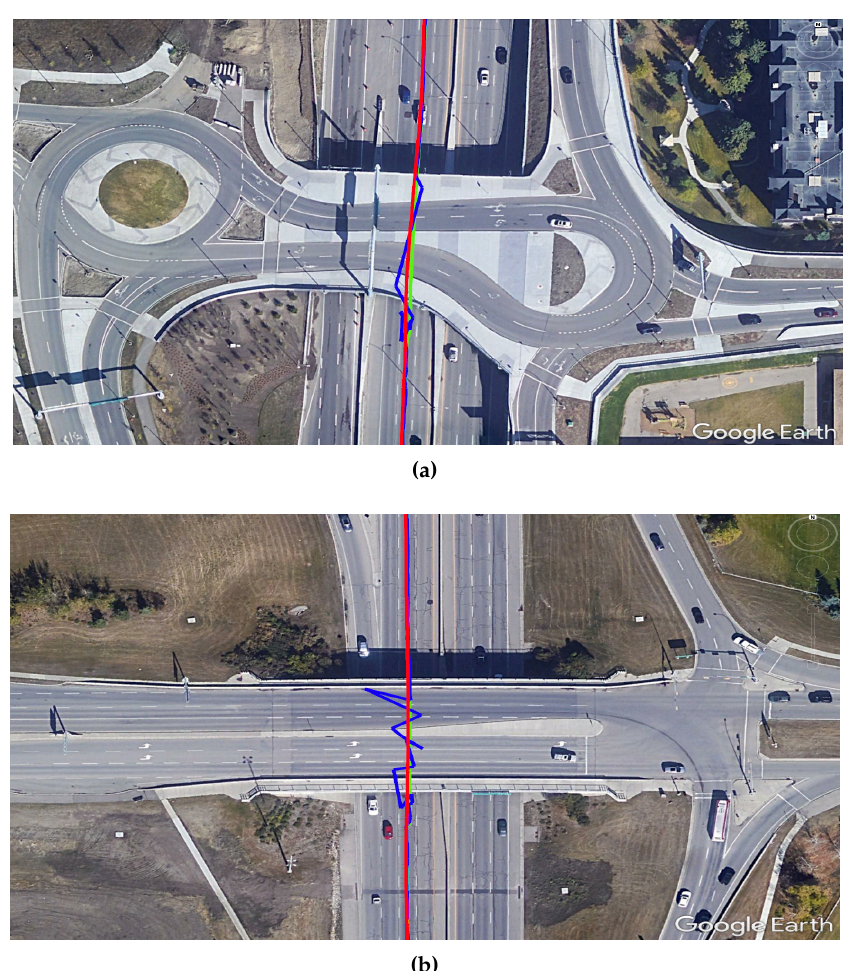
Figure 12. Two examples ( a ) and ( b ) of the developed SF-PPP/INS system performance on highways showing how the system could maintain a solution within the driving lane. The three displayed solutions are: reference (red), SF-PPP (blue), and integrated SF-PPP/INS